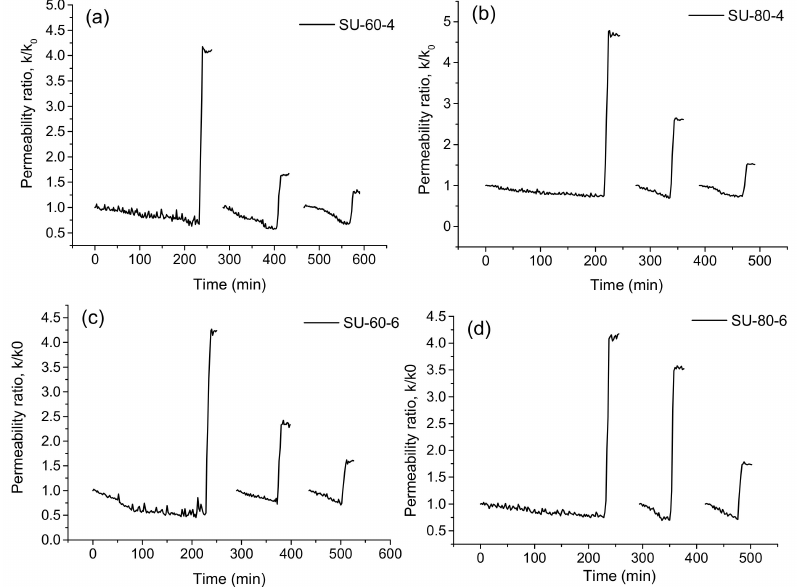
Figure 7. Evolution of the permeability ratio with time under an N 2 injection with three cycles. ( a ) N 2 temperature is 60 ◦ C, and N 2 injection Pressure is 4MPa. ( b ) N 2 temperature is 80 ◦ C, and N 2 injection Pressure is 4MPa. ( c ) N 2 temperature is 80 ◦ C, and N 2 injection Pressure is 6MPa. ( d ) N 2 temperature is 80 ◦ C, and N 2 injection Pressure is